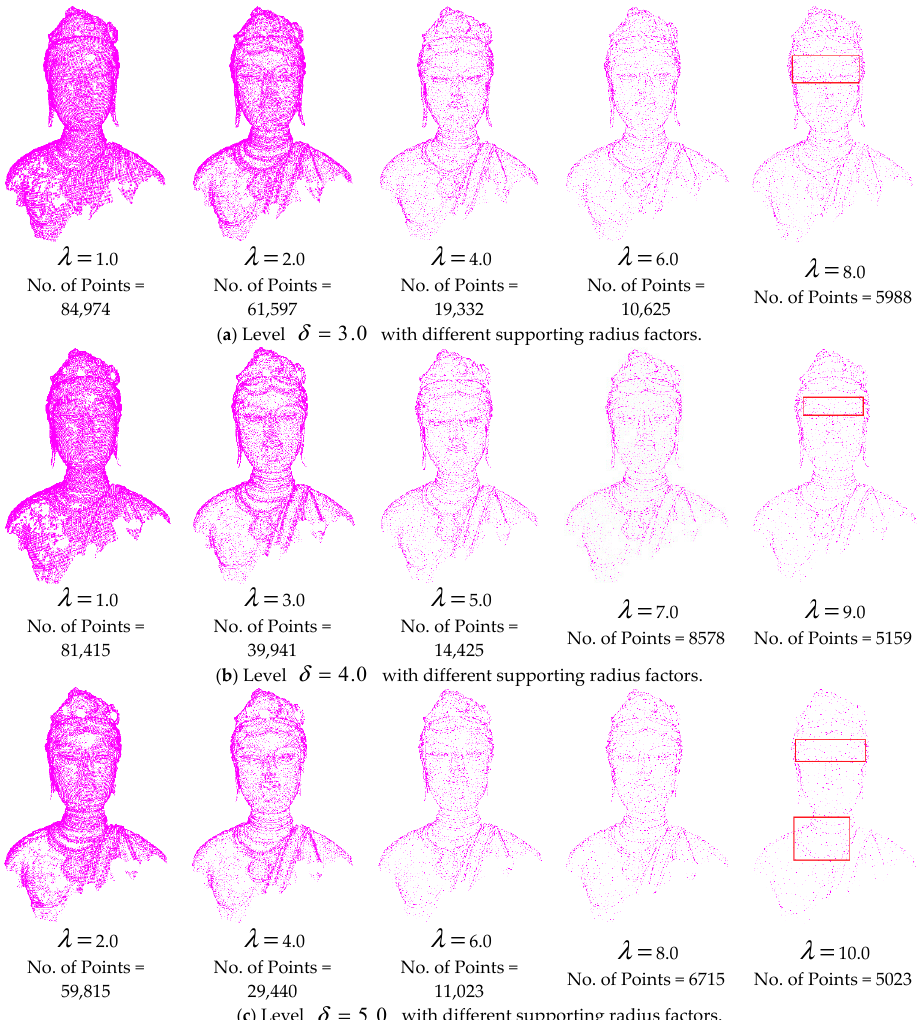
Figure 14. Levels with different supporting radius factors ( W = 5.0).